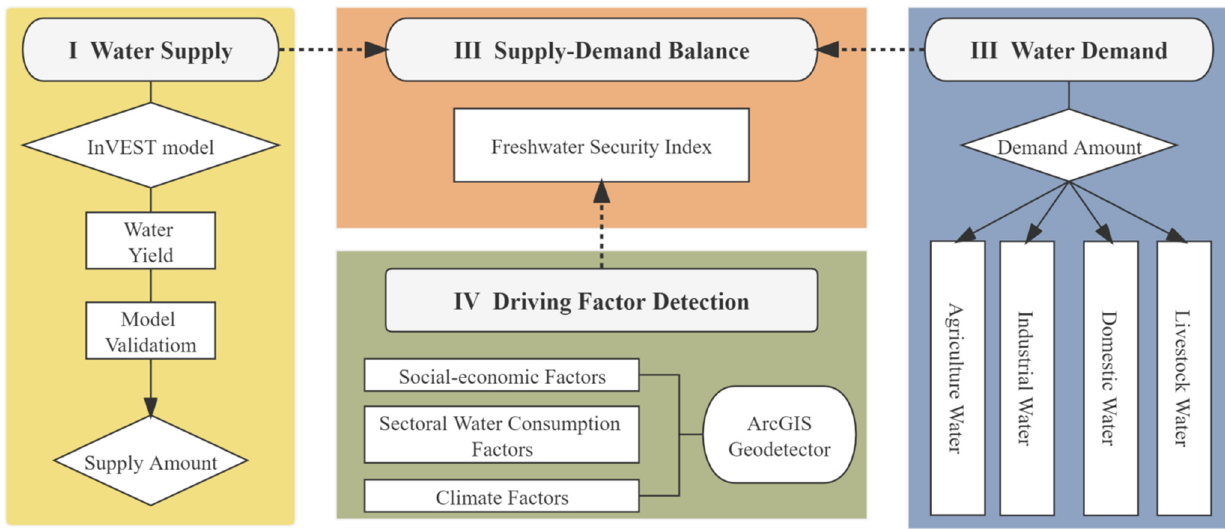
Figure 2. The modeling framework of water supply services in the Three Gorges Reservoir Area.